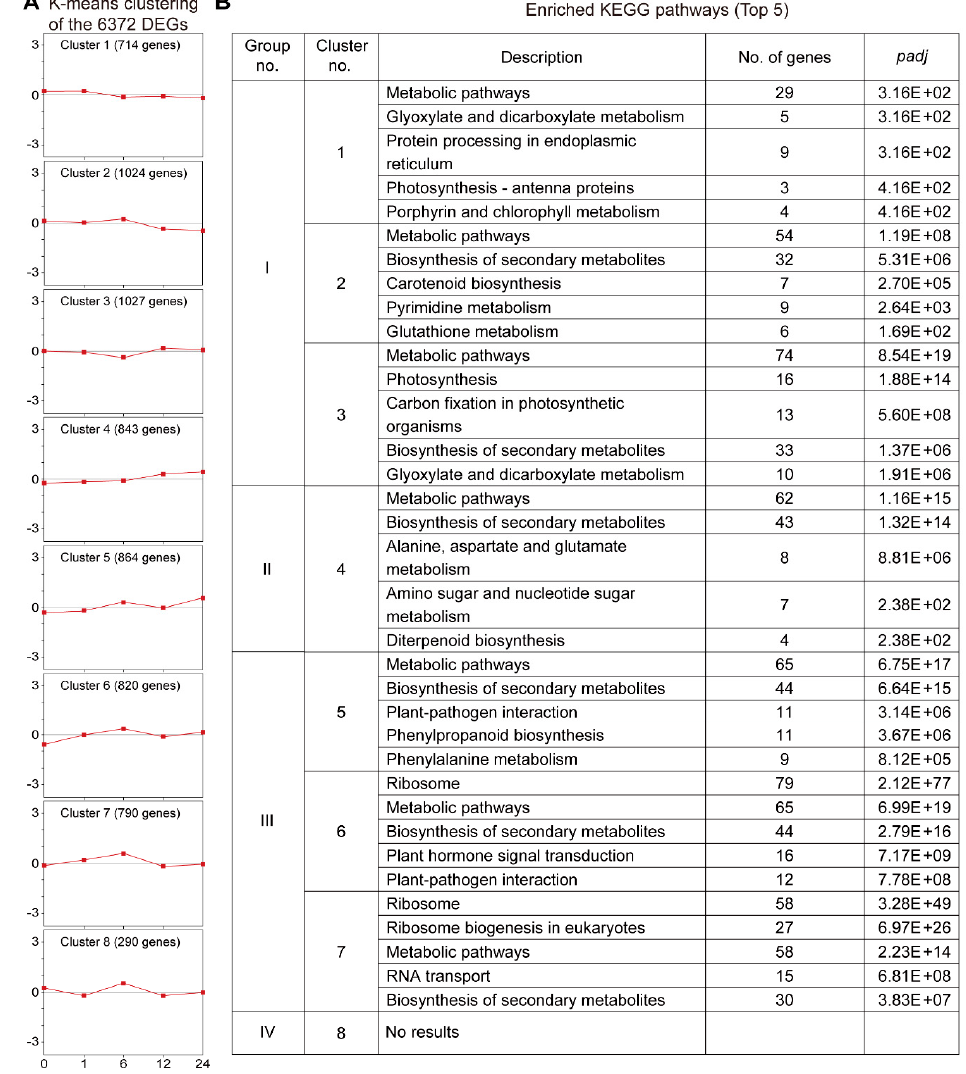
Figure 6. Kyoto Encyclopedia of Genes and Genomes (KEGG) enrichment analysis of differentially expressed genes (DEGs) grouped by the K -means clustering method. ( A ) K -means clustering of differentially expressed genes scaled as Z-score. Eight clusters involving 6372 DEGs induced by C. medinalis feeding. The number of genes in each cluster is indicated. The expression data for individual genes are shown in light grey, and the average expression for each cluster is shown in red. The x-axis shows the different feeding stages and the y-axis shows the Z-scores. ( B ) KEGG enrichment analysis of genes in each cluster. The top five significantly enriched pathways are listed for each cluster. “No results” indicates that there were no significantly enriched KEGG terms.